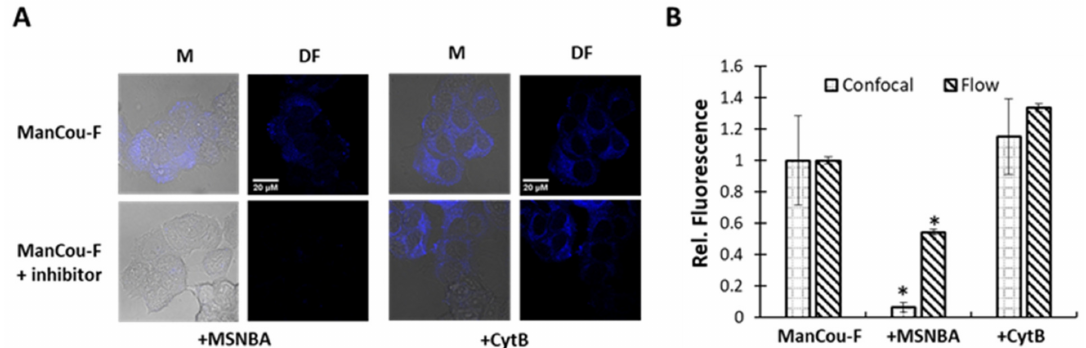
Figure 5. ManCou-F uptake (25 µ M) in the presence of MSNBA (25 µ M) and cytochalasin B (CytB, 25 µ M). ( A ) Images were acquired using a 60 × objective and DAPI filter (exc/em: 405 nm/461 nm) at the same laser intensity and exposure time, DF—dark field, and M—fluorescence overlay images with the bright field. Each experiment was carried out in duplicate. ( B ) Analysis of probe-induced fluorescence by confocal microscopy and flow cytometry. For microscopy analysis, data represent fluorescence derived after quantification of fluorescence images using ImageJ as CTCF/Area. Fluores- cence obtained by Attune NxT Flow Cytometer using VL1 filter was processed as MFI probe (median of fluorescence intensity)-MFI negative (MFI of the cells with no treatment). Error bars represent the relative standard deviation. A two-tailed t -test was used to detect statistically significant differences: *— p < 0.05. Relative fluorescence is derived by normalization by the control (probe without inhibitor). The scale bar for all images is 20 µ